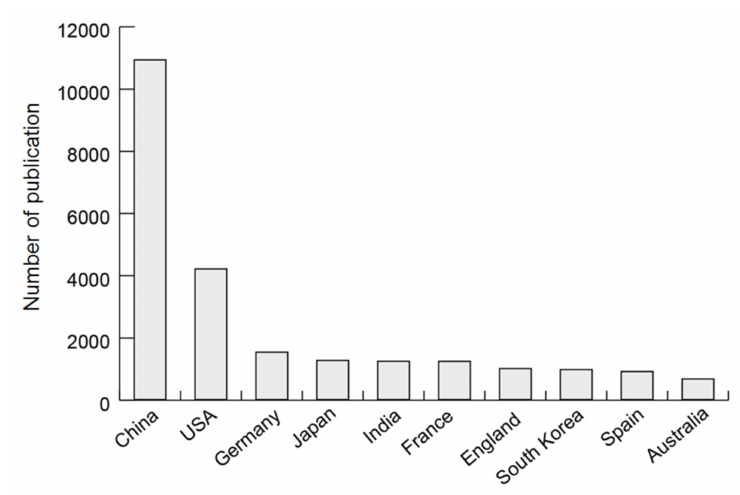
Figure 3. Number of publications from each country in MOF research area.